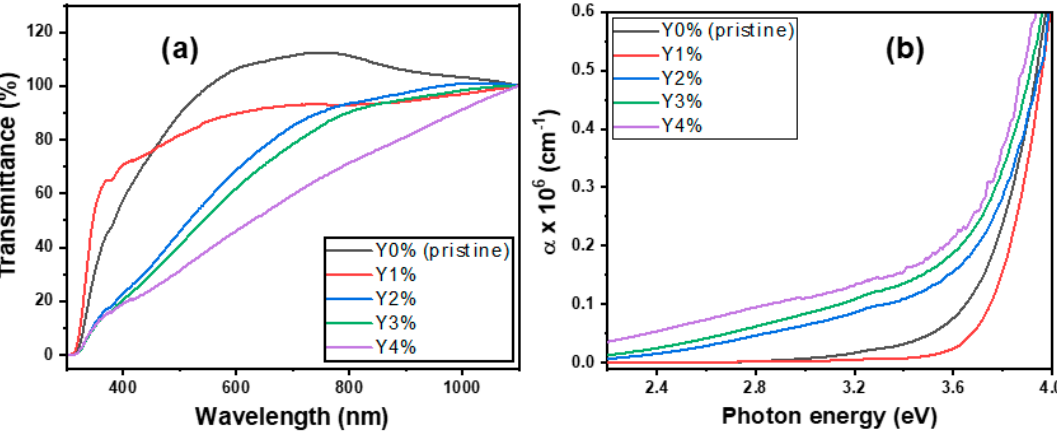
Figure 2. ( a ) Transmittance and ( b ) absorption coe ffi cient plots of pristine and composite films.